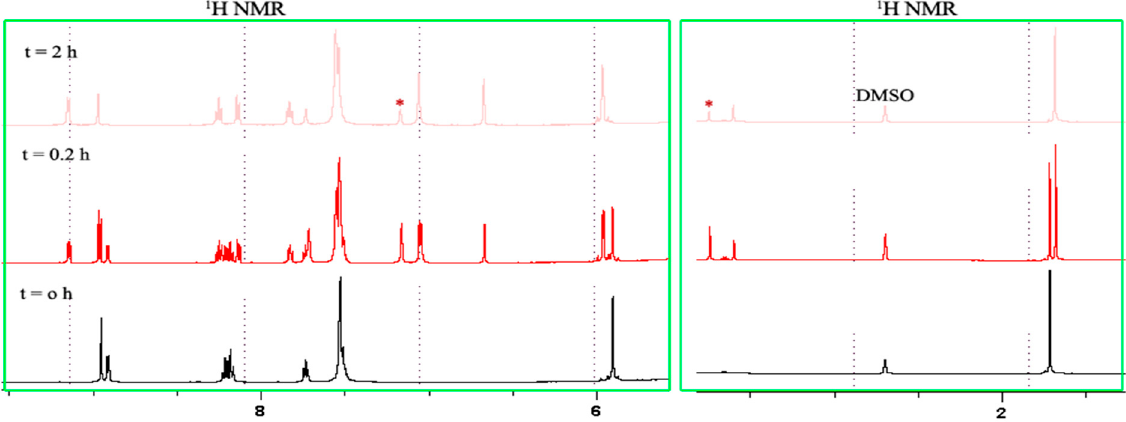
Figure 4. 1 H NMR spectra showing complete coordination of 1-methylimidazole to the chloride analogue of C5 within 2 h. The peaks with an asterisk (*) are from residual1-methylimidazole.